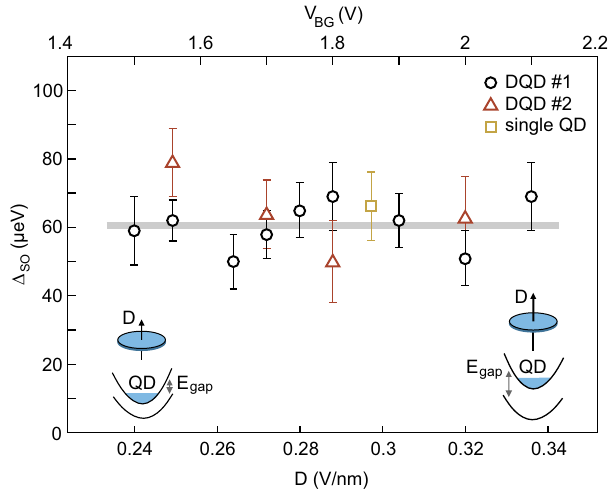
Fig. 5 Spin-orbit gap Δ SO as function of applied electric displacement fi eld, D . The black data points correspond to the device presented in the main manuscript (DQD #1) and the red data points to the second device (DQD #2) shown in Supplementary Fig. 2. The yellow data point is obtained from a single quantum dot (single QD) formed in a third device (see Supplementary Fig. 4). The errorbars represent the measurement uncertainties resulting from fi nite linewidths in the measurements. Over the entire displacement fi eld range, Δ SO ≈ 60 μ eV remains constant within the margin of uncertainty (see gray horizontal line). Note that the V BG -scale (upper horizontal axis) is valid only for the two double QD devices but slightly off for the single QD. Inset: Schematic illustration of the band structure of BLG with a small and a large applied out-of-plane displacement fi eld, which breaks the inversion symmetry and leads to the opening of a band gap ( E gap ) while Δ SO remains